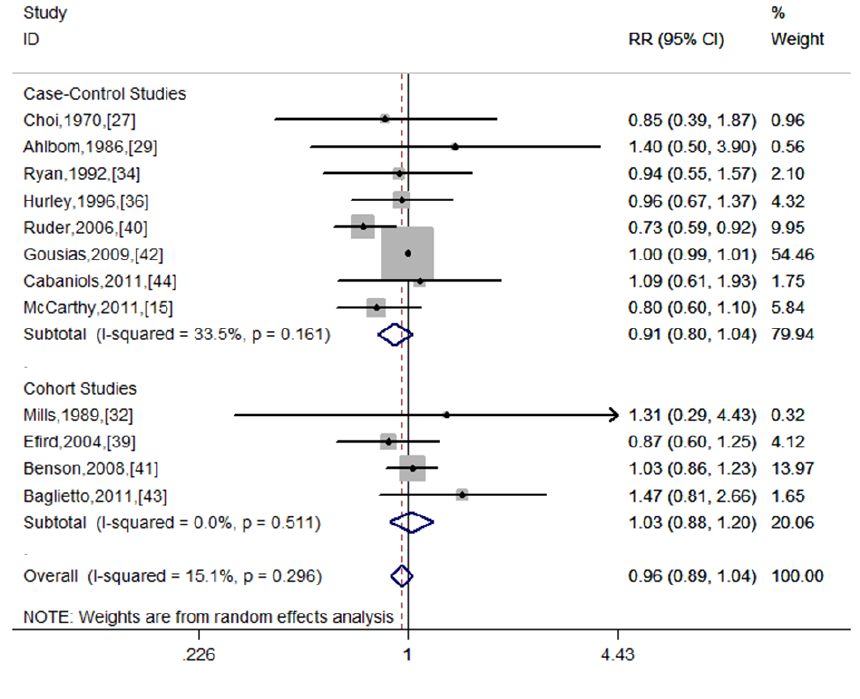
Figure 2. Forest plot for total alcohol drinkers versus